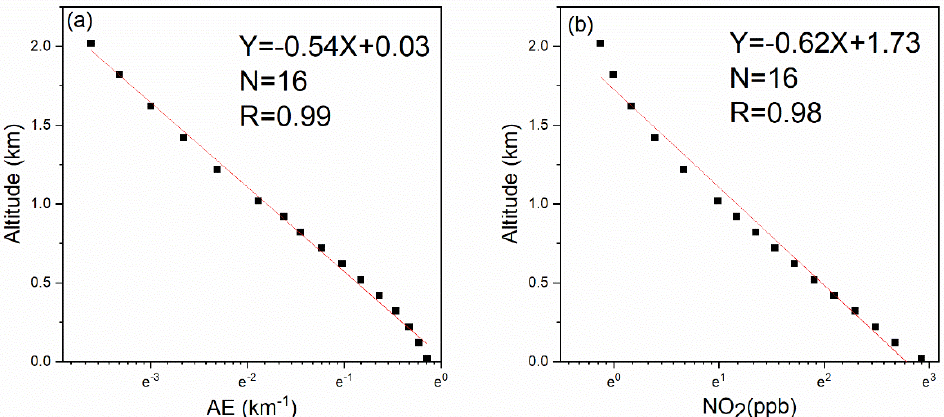
Figure 7. ( a ) Linear fitting between averaged aerosol extinction coefficients and altitudes, here X is natural logarithmic coordinate; ( b ) Linear fitting between averaged NO 2 concentrations and altitudes, here X is natural logarithmic coordinate. Significance level ( p ) <